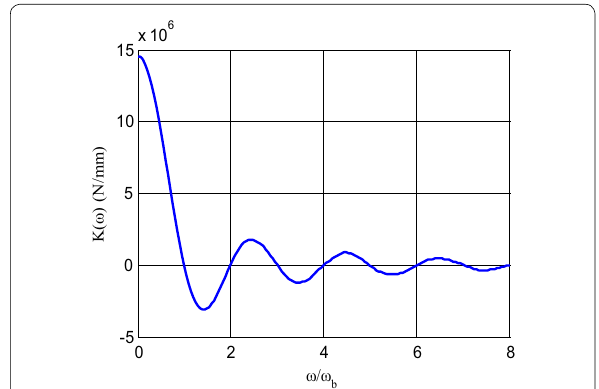
Figure 8 Relationship between the wavelength and error averaging effect of a single carriage